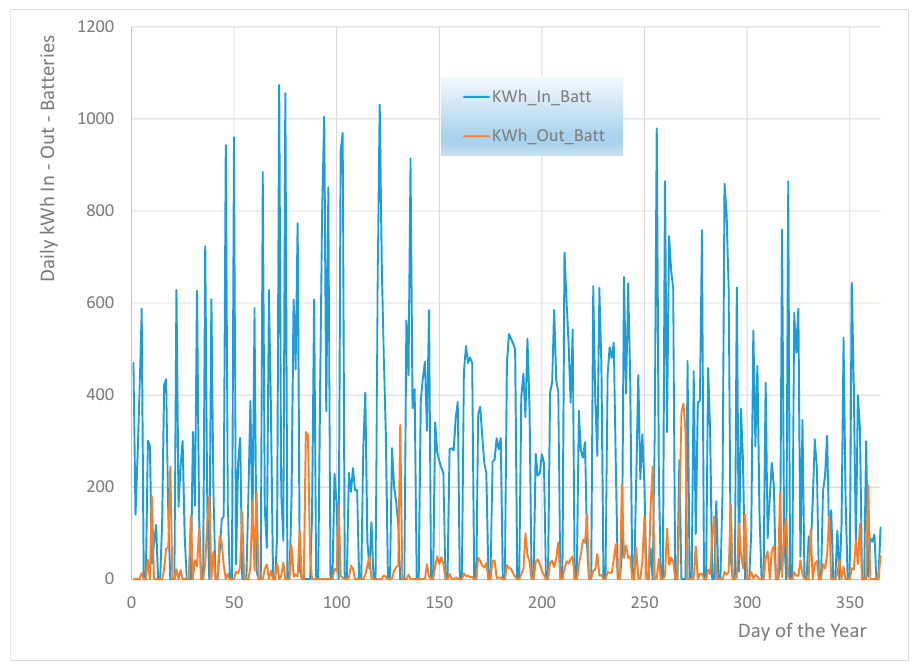
Figure 8. Daily electricity input to and extraction from the EV owners’ batteries (kWh) while they stay connected in the building’s micro grid.